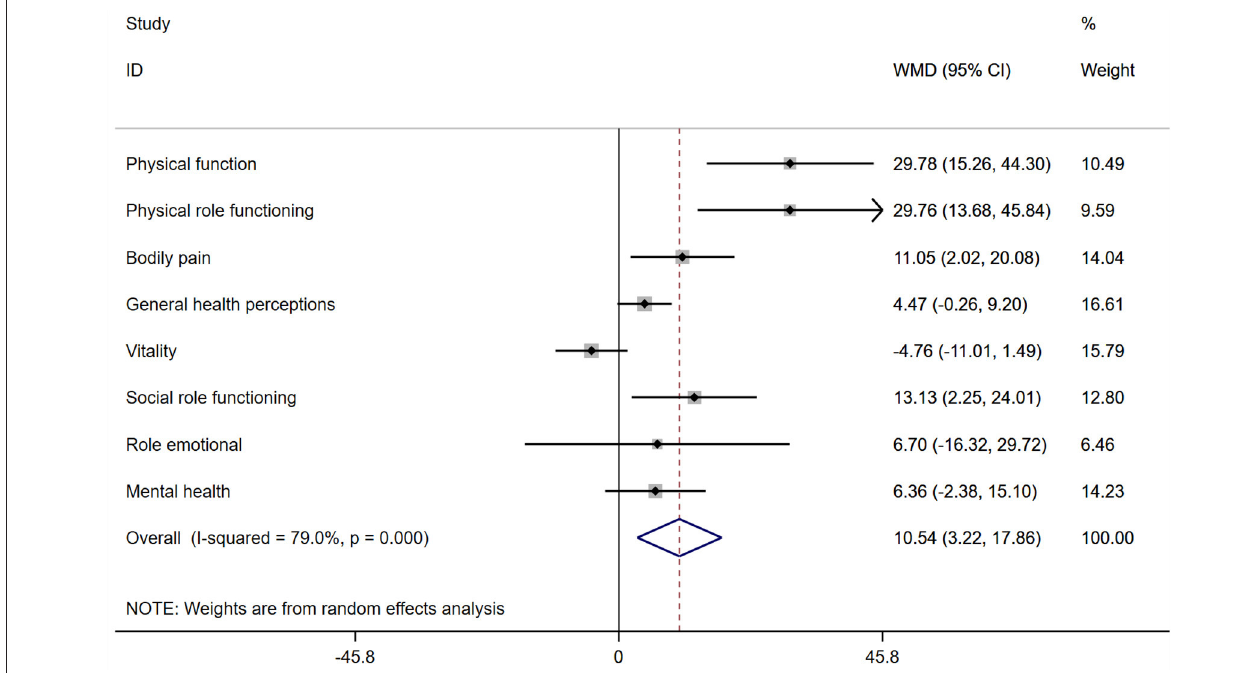
FIGURE 3 | Forest plots for the quality of life. IV, inverse variance.